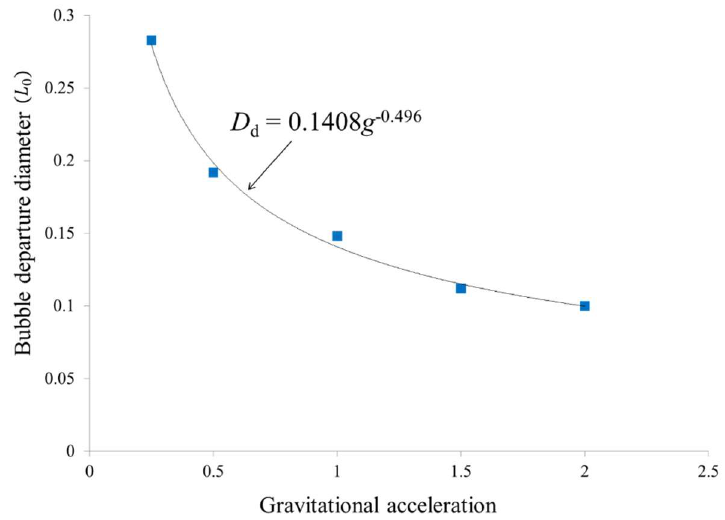
Figure 3. Departure diameter as a function of gravitational acceleration. Reprinted with permission from [20]. Copyright 2018 Elsevier.